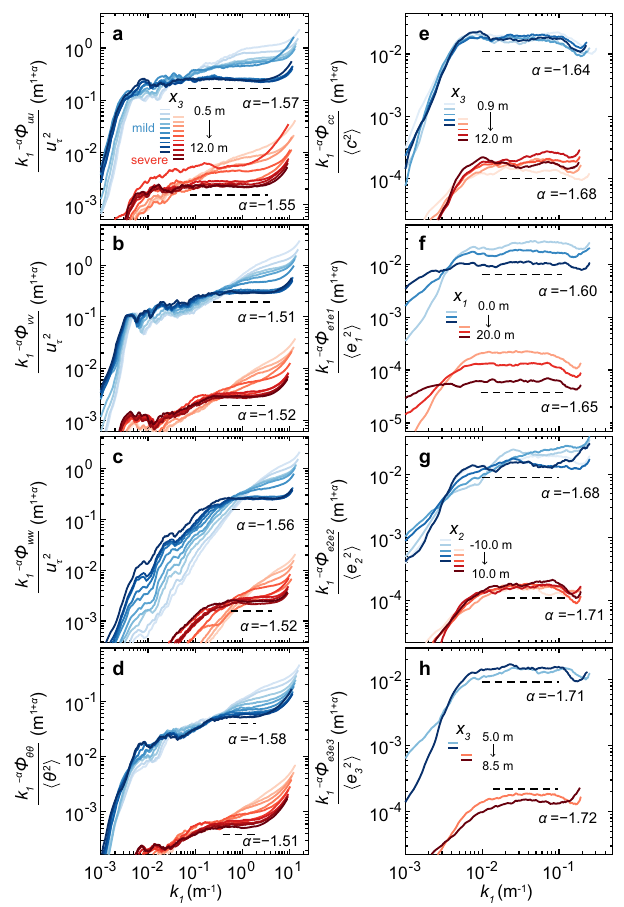
Fig. 3 | Compensated one-dimensional PSDs of the fl uctuating fi elds for the observed mild (blue lines) and severe (red lines) dust storm datasets. a – h The compensated velocity PSDs (streamwise component k (cid:2) α 1 ϕ uu , spanwise compo- nent k (cid:2) α 1 ϕ vv ,andverticalcomponent k (cid:2) α 1 ϕ ww )aredividedbythesquaredfriction velocity ( u 2 τ ), whereas the compensated PSDs of the ambient temperatures ( k (cid:2) α 1 ϕ θθ ), PM10 dust concentrations ( k (cid:2) α 1 ϕ cc ), and electric fi elds (streamwise , spanwise component k (cid:2) α 1 ϕ e , and vertical component component k (cid:2) α 1 ϕ e 1 e 1 2 e 2 k (cid:2)